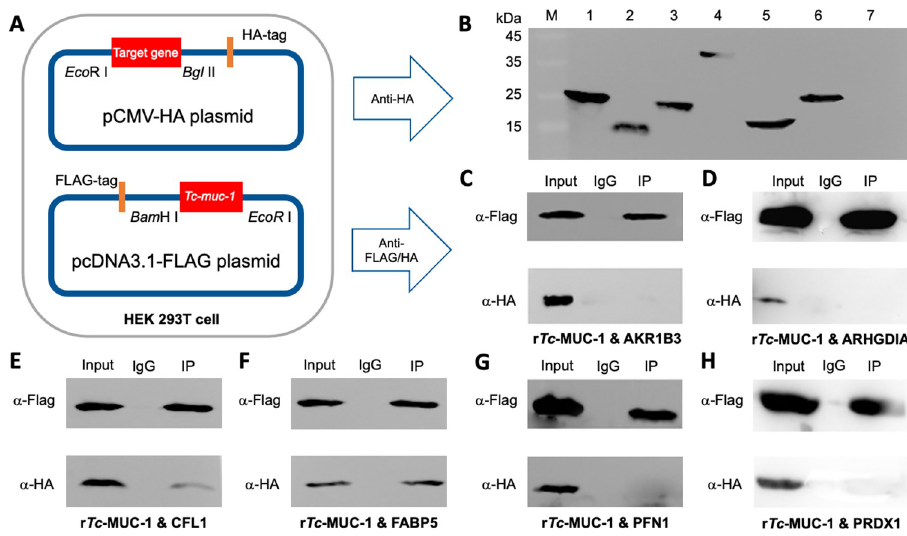
Fig 3. Co-immunoprecipitation analysis of proteins of murine macrophages bound to recombinant Toxocara